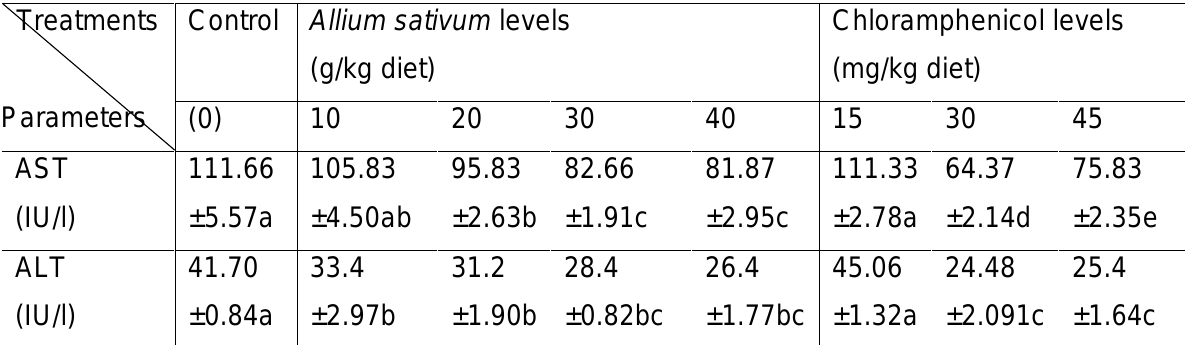
Chloramphenicol levels (mg/kg diet)